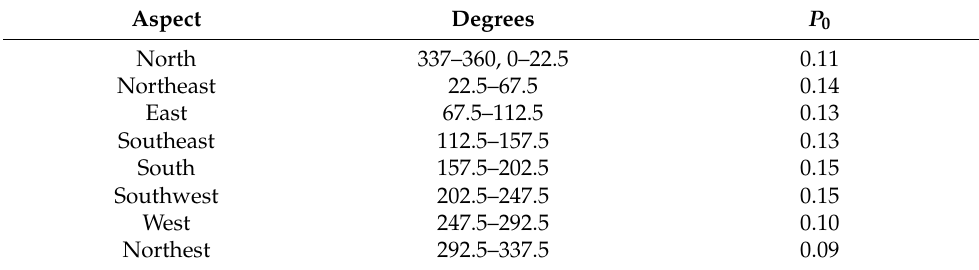
Table 11. Classification of